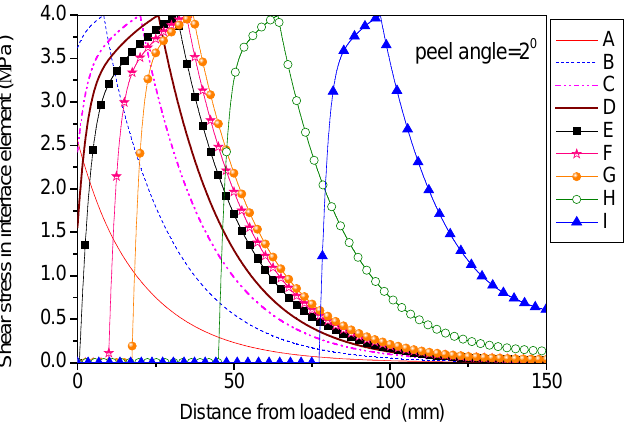
Figure 19. Normal stress distribution along the interface at different load levels when the peel angle = 2 degree.